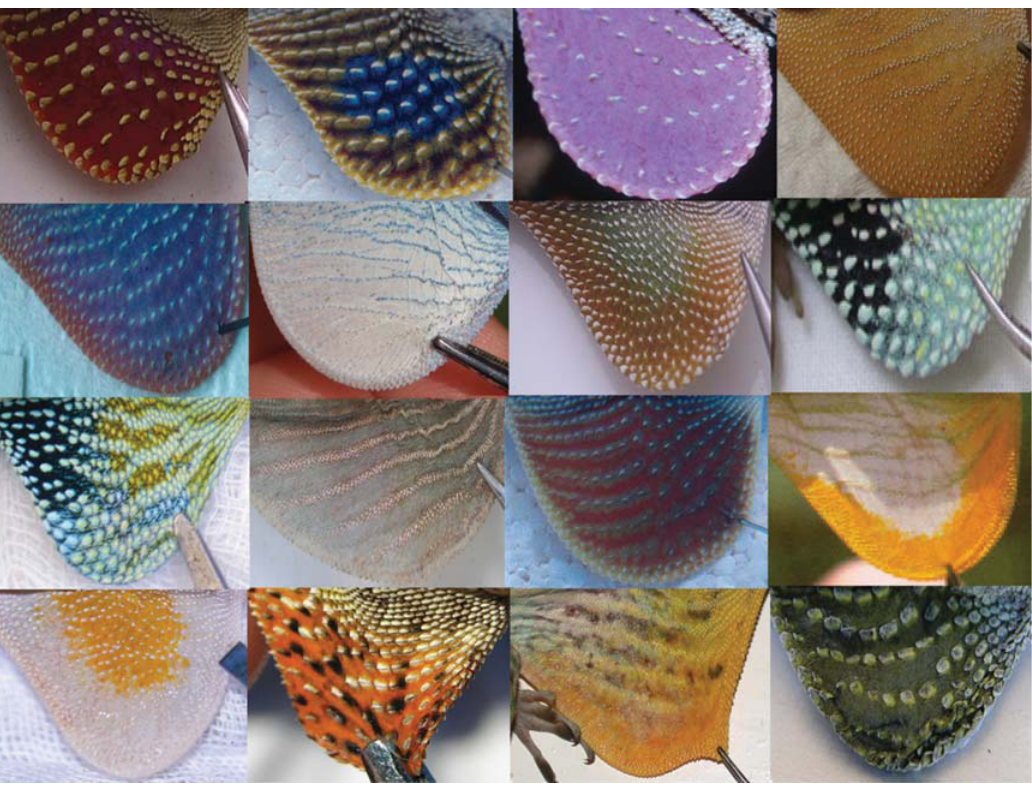
Figure 1. A small sample of Anolis dewlaps exemplifying observed morphological diversity. Some images are modified from original photographs and used with permission from David Hillis and Richard Glor. Species depicted are as follows (in order right to left and top to bottom): A. pulchellus, A. sericeus, A. liogaster, A. longitibalis, A. cobanensis, A. gorgonae, A. cristatellus, A. chlorocyanus, A. reconditus, A. christophei, A. cuprinus, A. new species, A. lineatopus, A. annectens, A. baleatus, A. auratus